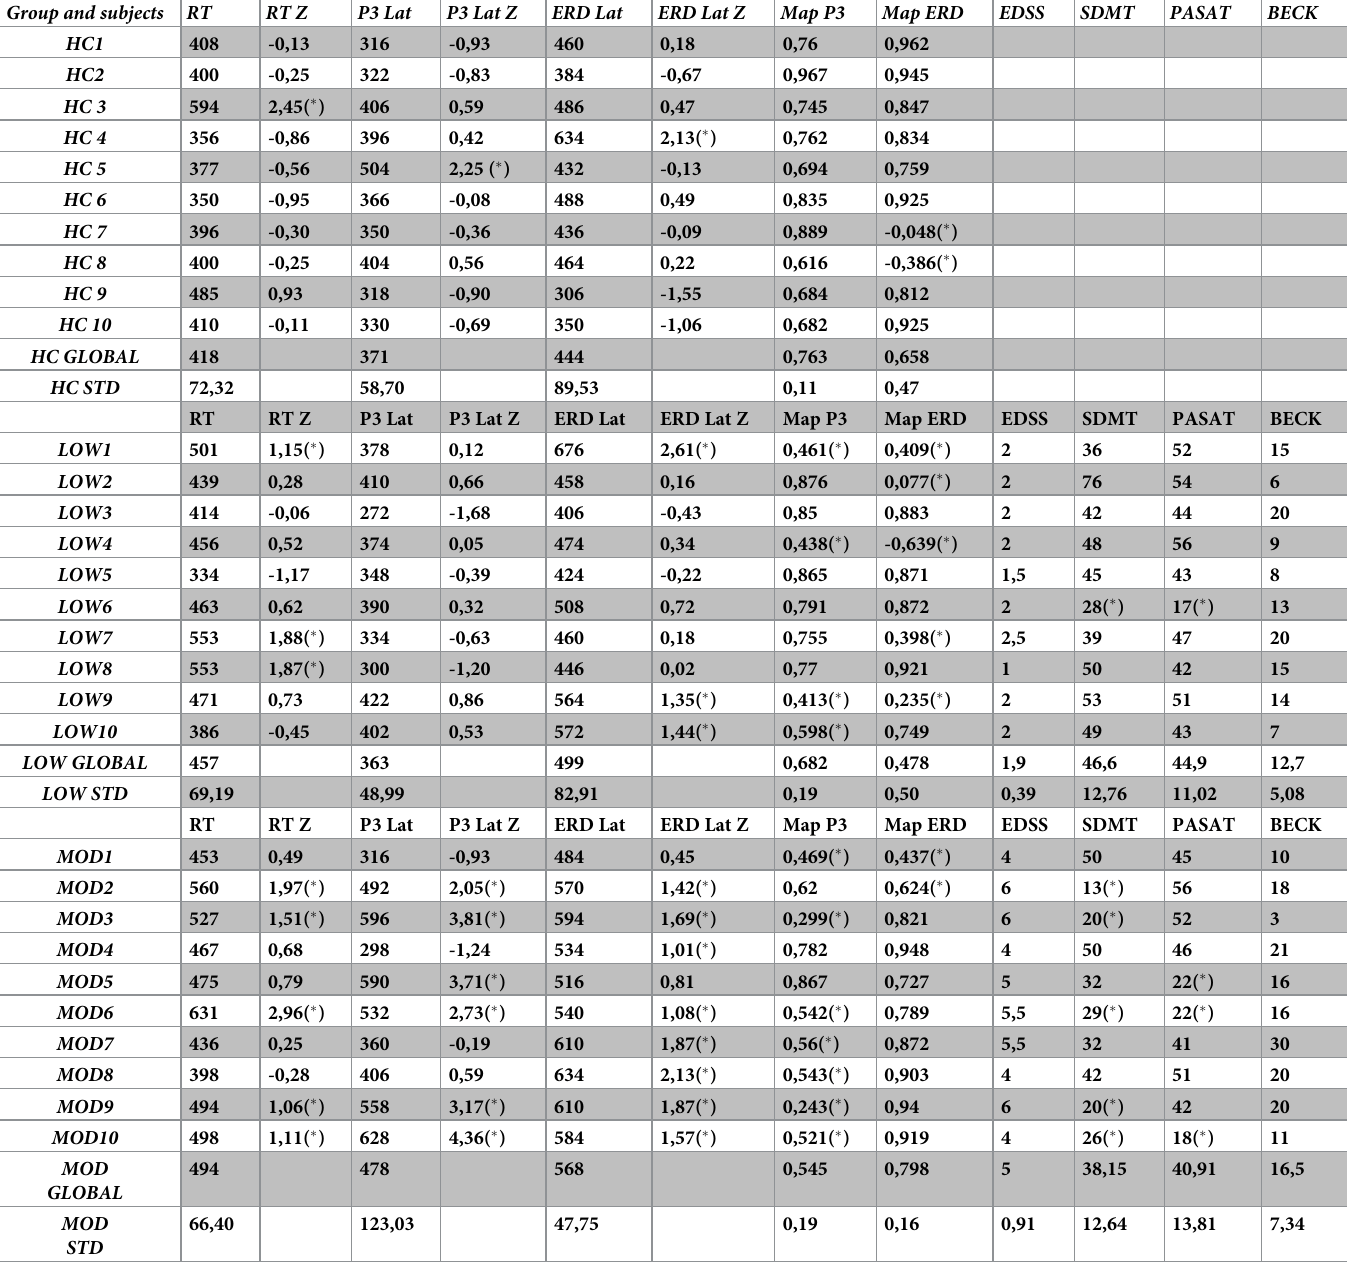
Table 2. Individual behavioral, neuropsychological and EEG parameters in three experimental groups. Group and subjects